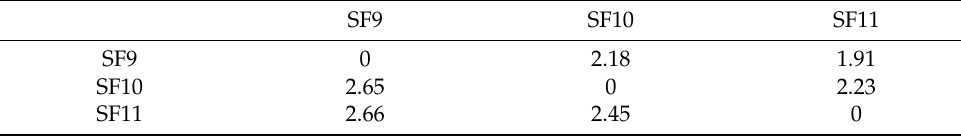
Table A4. Aggregated crisp direct-relation matrix for Adaptability matrix.